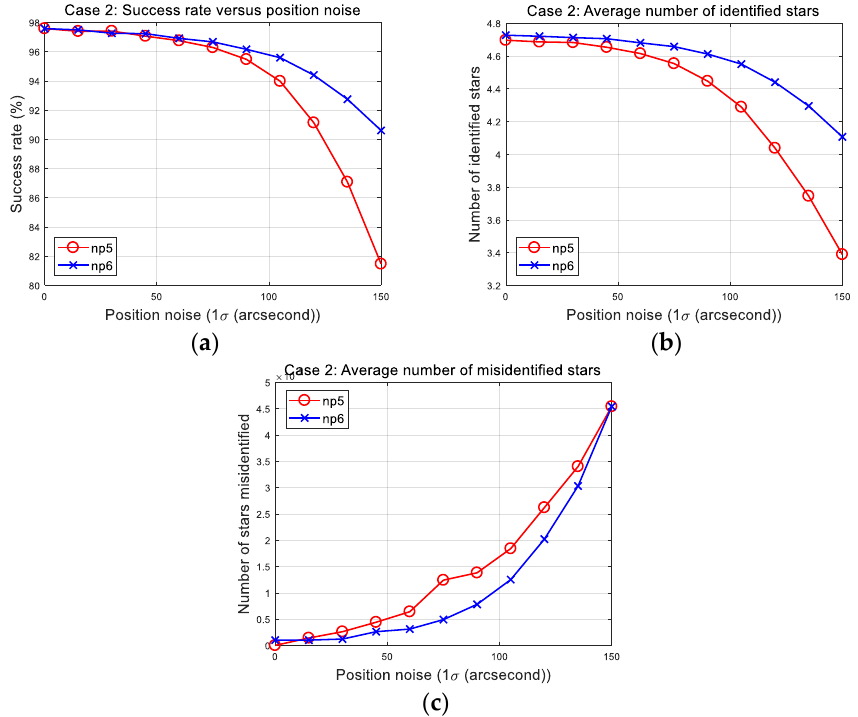
Figure 12. Case 2: Parameter study of patterns using the nearest five and six stars. ( a ) Success rates; ( b ) number of identified stars; ( c ) number of misidentified stars.